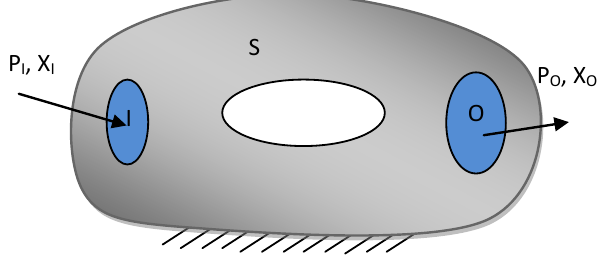
Figure 2. Inputs and outputs of a CM.